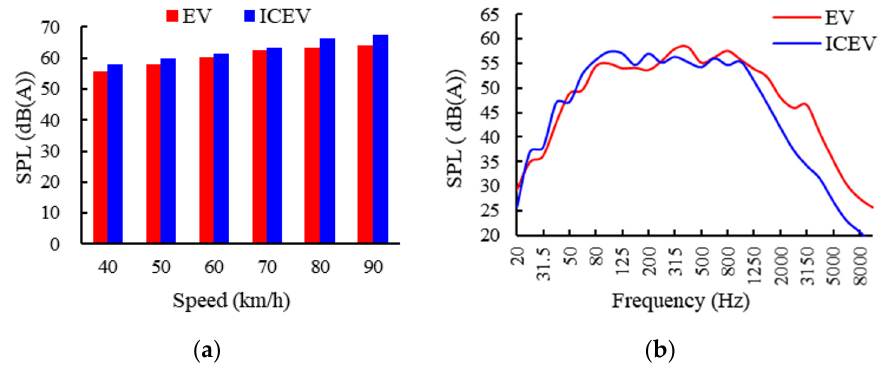
Figure 1. Comparison of the interior noise between electric vehicles (EVs) and internal combustion engine vehicles (ICEVs): ( a ) comparison of the interior noise level between EVs and ICEVs at different constant speeds; ( b ) comparison of the noise spectrum in EVs and ICEVs at a certain constant speed. SPL, sound pressure level.